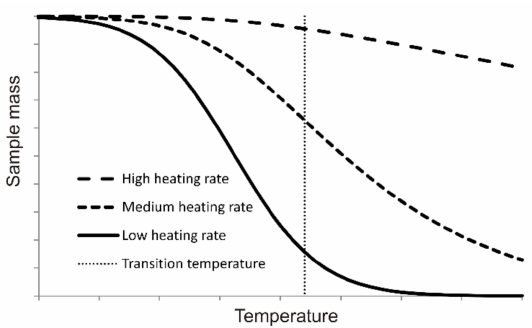
Figure 2. Schematic dependence of the behavior of TG-curves on the heating